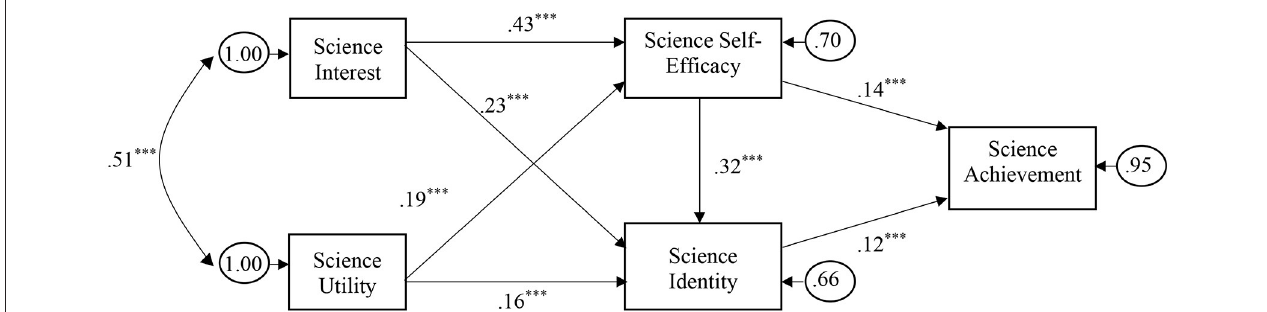
FIGURE 2 | PA model with standardized parameters. The double-headed curved arrow implies the covariance between the variance terms of the exogenous variables, which are, in this case, science utility and science interest. The right-to-left arrows and associated figures in circles pointing toward science interest and utility are variance terms, which are estimated as 1, implying that the model did not explain the variances of these variables. The remaining three variables (i.e., science self-efficacy, science identity, and science achievement) are endogenous. The right-to-left arrows and associated figures in circles pointing toward these three variables are the residuals/unexplained variance terms of the endogenous variables due to error and other unmodeled variables. *** p < 0.001.